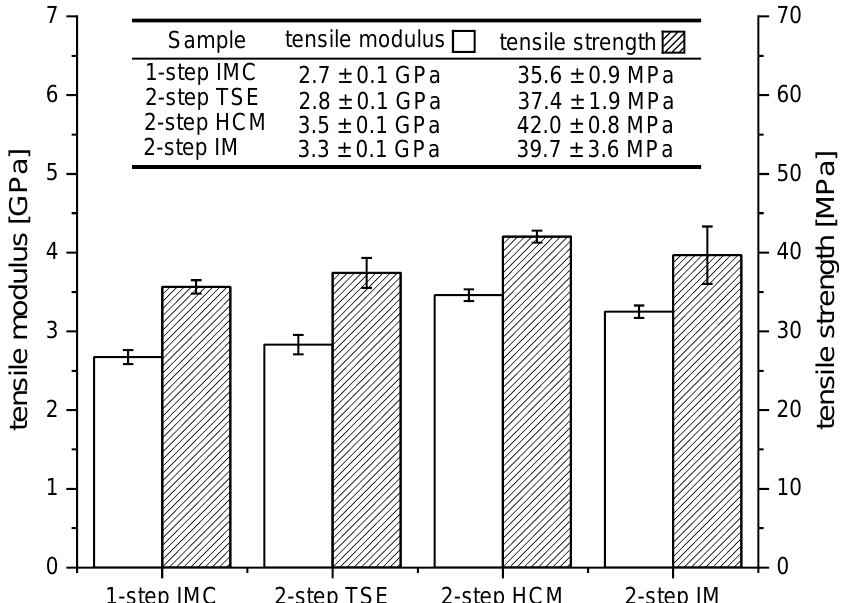
Figure 6. Tensile test according to ISO 527 at 30 wt.-% wood-fiber-reinforced PP; test specimens milled out of injection-molded sheets with s = 2 mm; n = 10; 𝑋̃ ± 𝑆𝐷 ; values deviate between 10 and 20% from injection-molded test specimens, according to ISO 527. Normal distribution confirmed for every group of specimens by Shapiro – Wilk test.